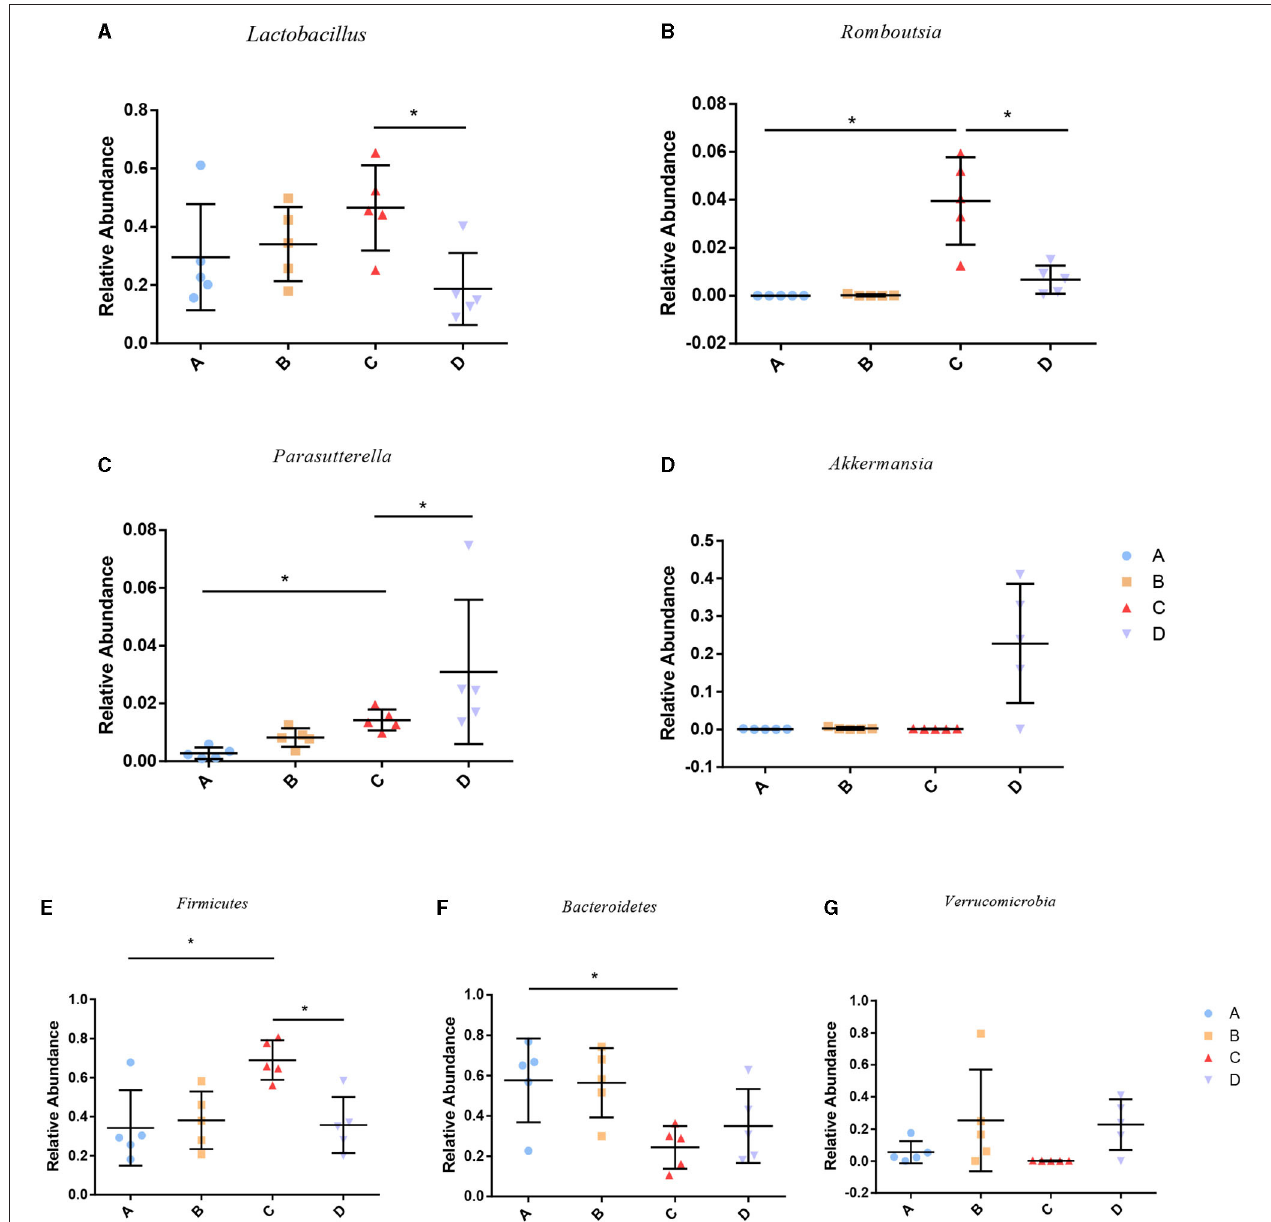
FIGURE 7 | Relative abundance of species among groups. (A) Lactobacillus ; (B) Romboutsia ; (C) Parasutterella ; (D) Akkermansia ; (E) Firmicutes ; (F) Bacteroidetes ; (G) Verrucomicrobia (* P < 0.05).